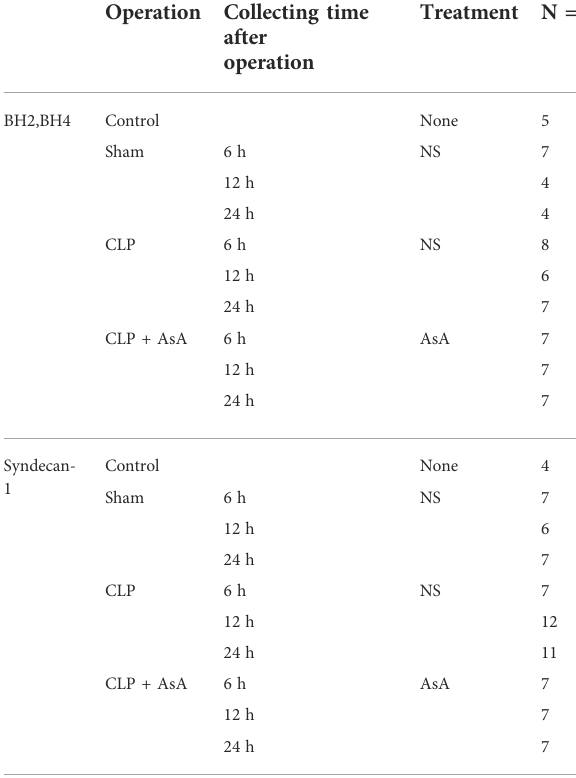
TABLE 2 Outcome measurement. p The numbers of each group deviated because some individuals died during the course of the study. Including the dead mice, the total is